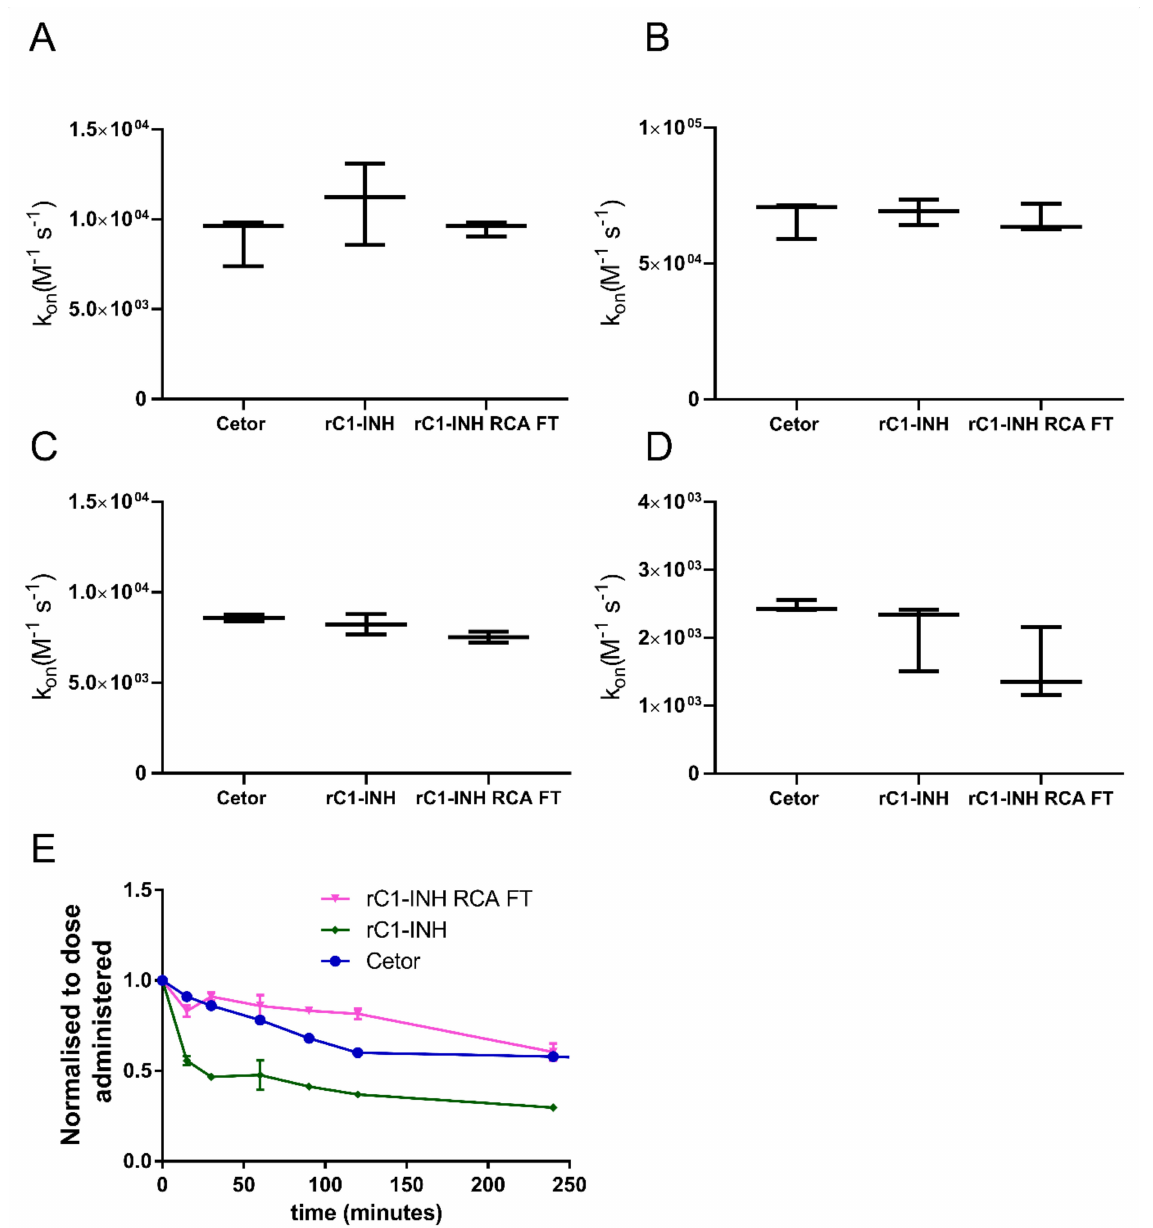
Figure 4. Function and half-life of rC1-INH without terminal galactoses. The association rate constants k on (M − 1 s − 1 ) for the inhibition of C1s ( A ), Kallikrein ( B ), Plasmin ( C ) and ( D ) FXIa by pdC1-INH, rC1-INH and rC1-INH RCA FT were determined. Values are means ± SD of three independent experiments, each performed in duplicate. No significant differences were observed. ( E ) The half-lives of pdC1-INH ( n = 2), rC1-INH ( n = 3) and rC1-INH RCA FT ( n = 2) show that the half-lives of pdC1-INH and rC1-INH RCA FT are similar, while the half-life of rC1-INH is clearly